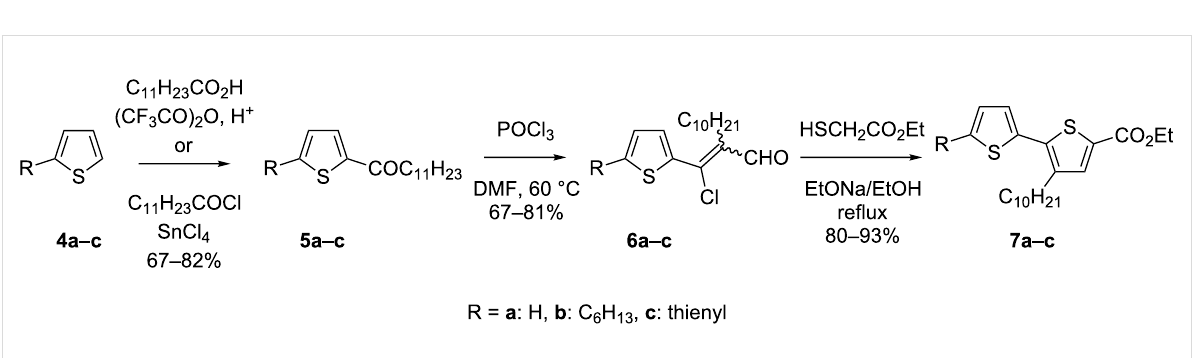
Figure 1: D–A compounds 1 – 3 .